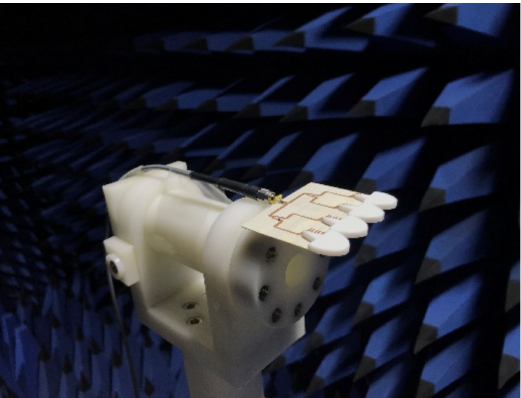
Figure 20. Measurement of the proposed antenna array scenario in the microwave anechoic chamber.